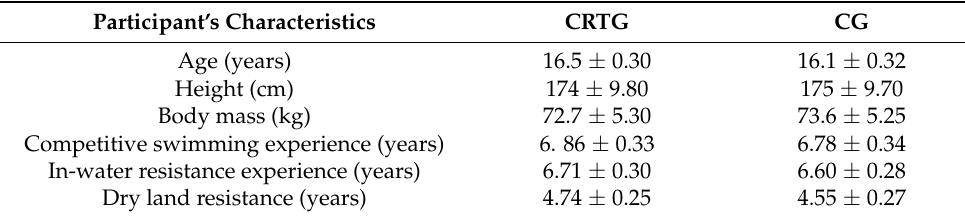
Table 1. Participant’s characteristics (mean ± SD) from the CRTG: concurrent resistance training group and CG: control